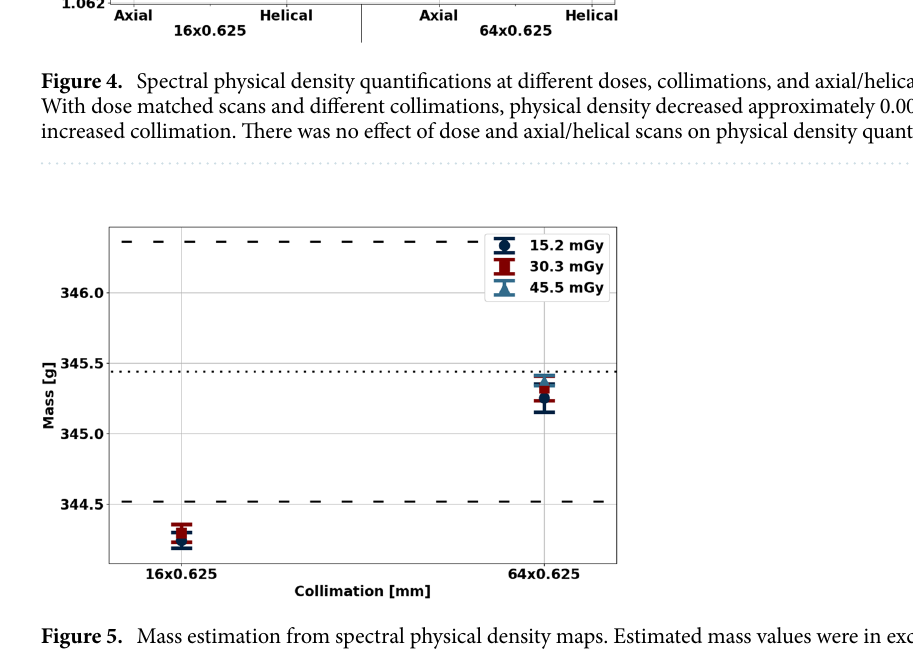
Figure 5. Mass estimation from spectral physical density maps. Estimated mass values were in excellent agreement with measured mass. The dotted line indicates the average mass from two weight measurements while the dashed line represents each independent weight measurement before (346.36 g) and after (344.52 g) CT scans.